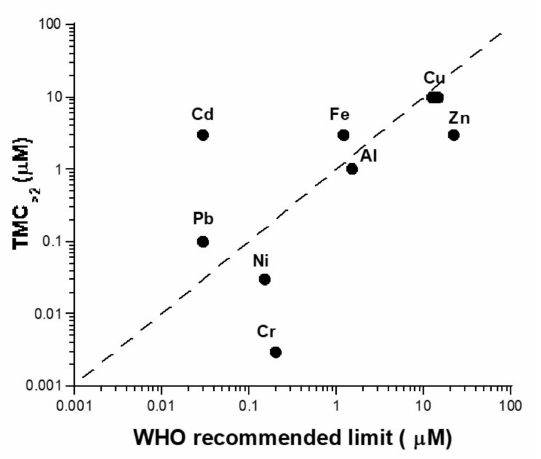
Figure 9. Comparison between TMC > 2 metal concentration limits in tap water. The TMC > 2 values shown in Tables 1 and 2 were plotted against the metal concentration limits in tap water recommended by the WHO (Table 2). The dotted line corresponds to a one-to-one